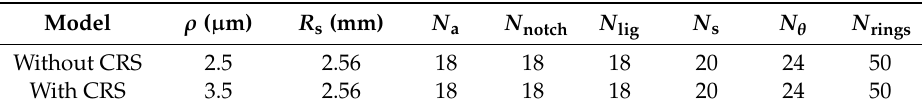
Table 1. Mesh division parameters of the finite element (FE) model of HT780 single-edged notched bend bar (SE(B)) specimens.